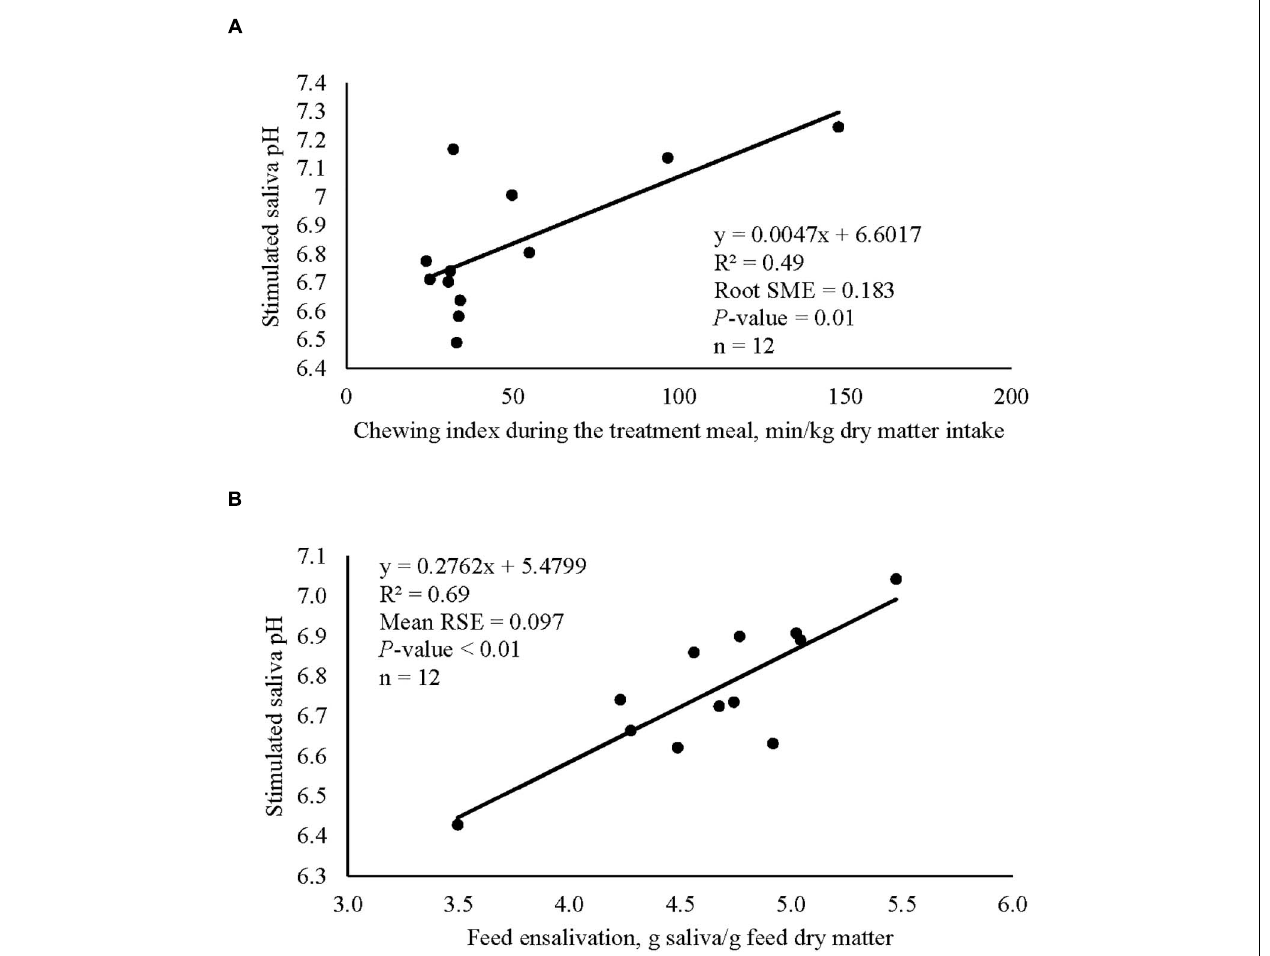
FIGURE 3 | Regression plots showing the association between stimulated salivary pH of cows and chewing index during the meal (A) , plot includes the averaged values of capsaicin and thyme oil, and the association between stimulated salivary pH and feed ensalivation (B) , plot includes the averaged values of capsaicin, garlic oil, gentian root, and mint